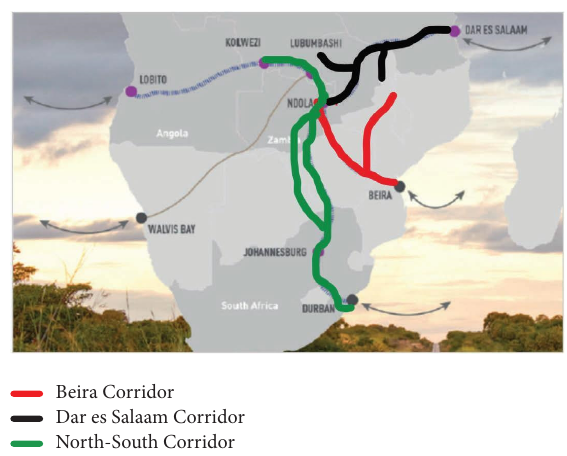
Figure 1: Te three competing corridors are Beira, Dar es Salaam, and